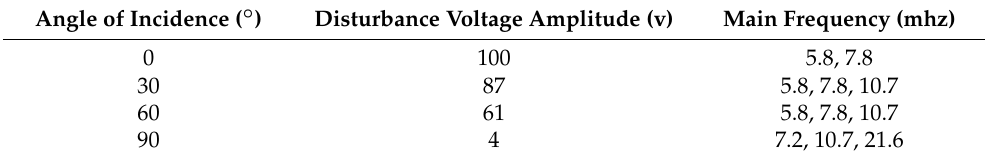
Table 3. The influence of the horizontal component of the magnetic field on the radiation disturbance. Angle of Incidence ( ◦ )